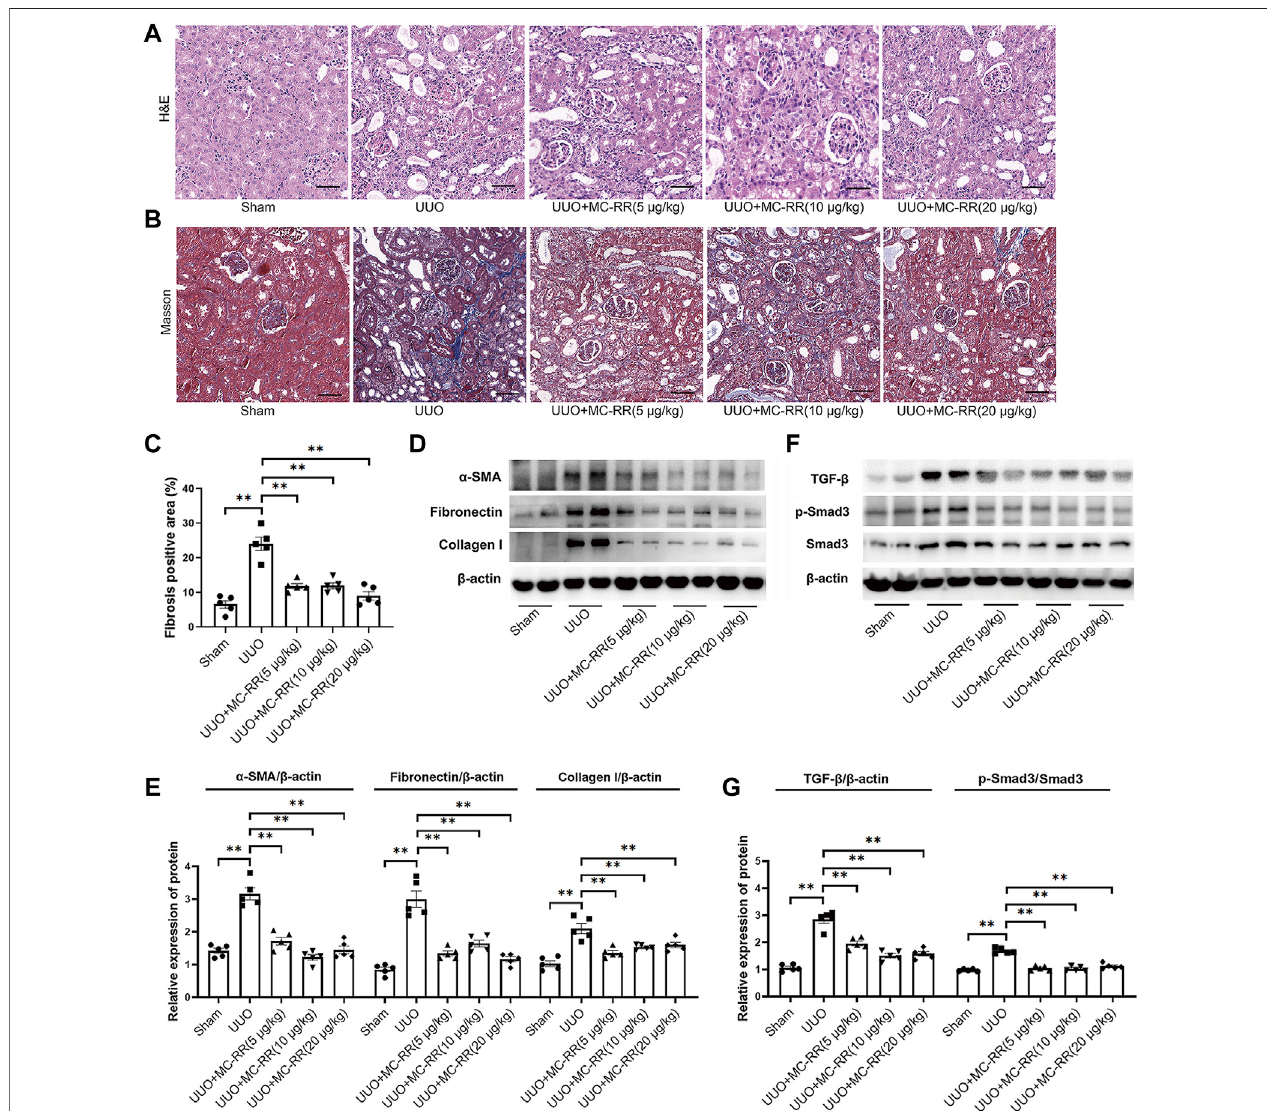
FIGURE2| Renoprotectioneffectofmicrocystin(MC)-RRindifferentdosesonunilateralureteralobstruction(UUO)mice.TheregimenofMC-RRwasusedinUUO mice. Twenty- fi ve mice were divided into fi ve groups, Sham, UUO, and UUO mice with treatment of MC-RR in three different doses (5, 10, and 20 μ g/kg/day), each group with 5 mice. (A,B) Kidney tissue sections were employed for H&E and Masson staining (scale bar: 40 μ m). (C) Fibrosis positive area in Masson staining were assessed by pathologist blind to this study ( n = 5). (D,E) Protein level of α -smooth muscle actin ( α -SMA), fi bronectin, and collagen I were measured in the renal tissues of UUO mice by western blot. (F,G) Protein expression of TGF- β , p-Smad3, and Smad3 in kidney tissue was measured by western blot. * p < 0.05, ** p < 0.01 determined by one-way ANOVA with S – N – K post hoc analysis.